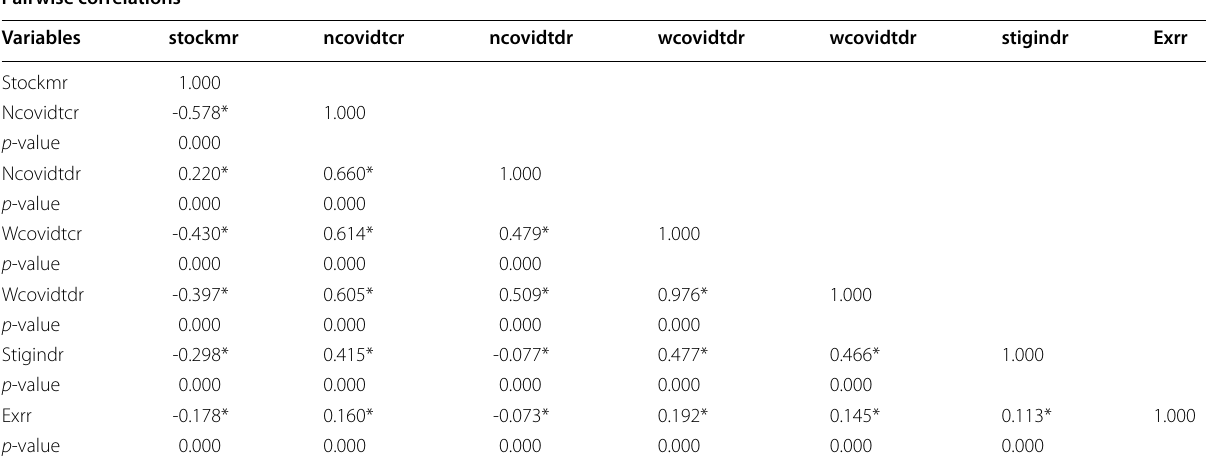
Table 3 Correlation matrices